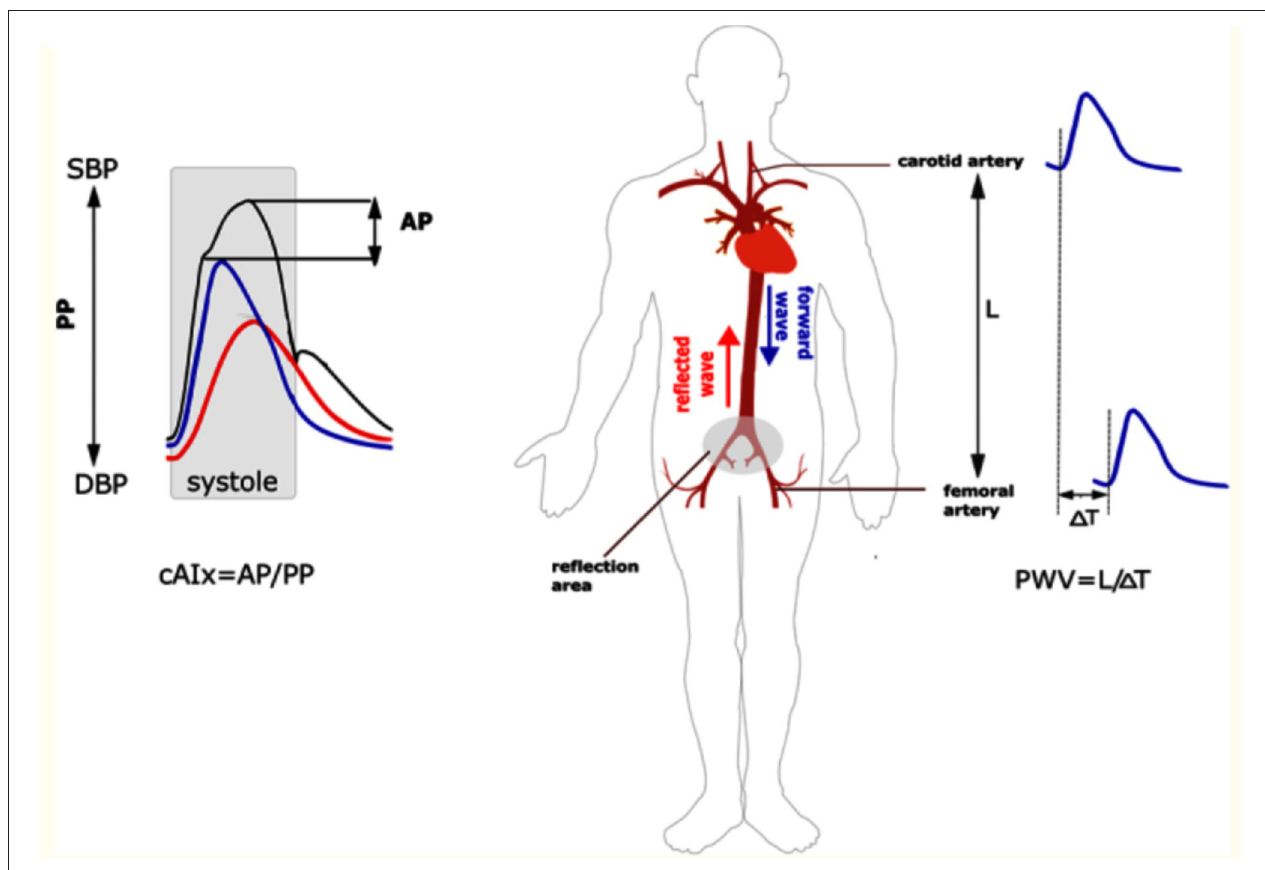
FIGURE 1 | Measurement of augmentation index and cfPWV. On the left panel, the central augmentation index is calculated as the ratio of the augmentation pressure over the pulse pressure. On the right panel, the cfPWV is measured by evaluating waveforms at the common carotid and femoral artery. This is the foot-to-foot method as it measures the beginning of the waveform at each site. The velocity component is then calculated by measuring the distance between the two sites divided by the time it takes for the waveform to travel from site to site. AP, augmentation pressure; PP, pulse pressure; cAIx, central augmentation index; PWV, pulse wave velocity; SBP, systolic blood pressure; DBP, diastolic blood pressure. Reproduced from